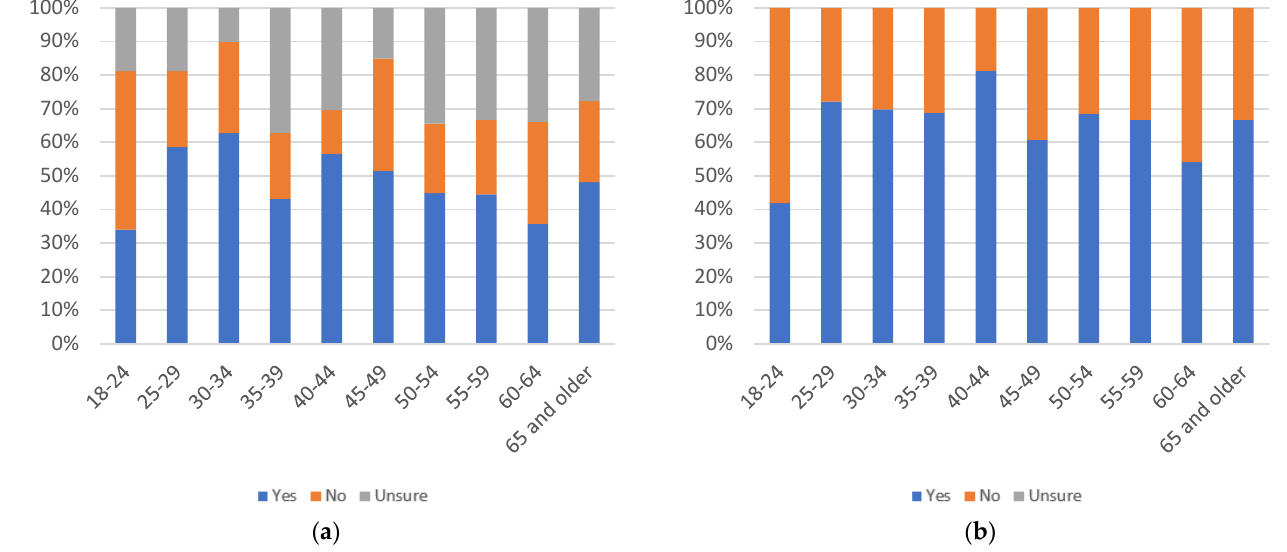
Figure 46. Label others’ use, by age group: ( a ) with uncertain respondents (left) and ( b ) without uncertain respondents (right).